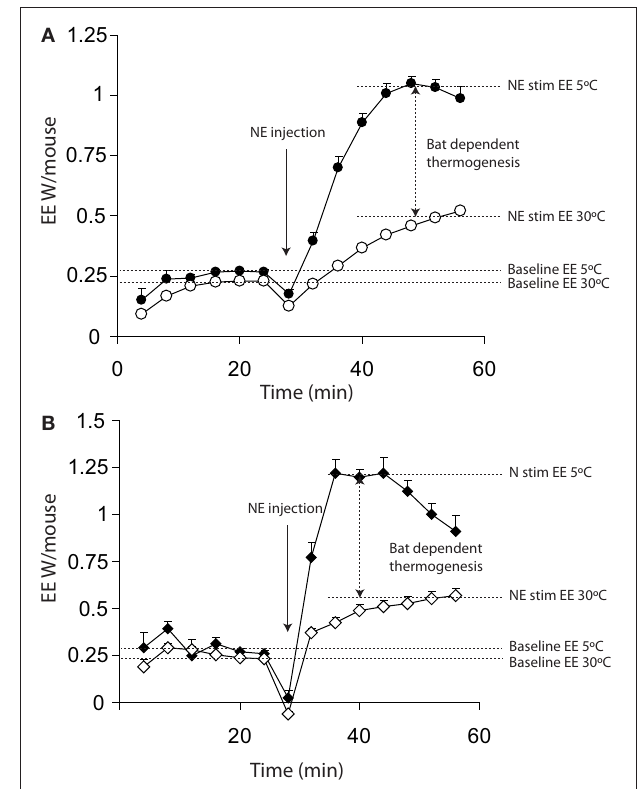
FIGURE 1 | Energy expenditure from 11 warm acclimated (30 ◦ C for 3 weeks) and 8 cold acclimated (5 ◦ C for 3 weeks) mice. Mice were injected with 1mg/kg norepinephrine at the time point indicted. All mice were anaesthetized with 60mg/kg pentobarbital and measured at 30 ◦ C, regardless of prior acclimation temperature. (A) Energy expenditure uncorrected for lag showing a successive increase in energy expenditure between 0 and 16 (prior to injection but following the mouse being place in the chamber) minutes and 24 and 40min (post injection with norepinephrine). (B) The same data as shown in panel (A) corrected for lag, showing apparently more rapid changes in energy expenditure. All mice; male, C57Bl/6, 4 months of age, chamber volume 2.7 l. Energy expenditure measurements conducted using a custom built calorimetry system, using